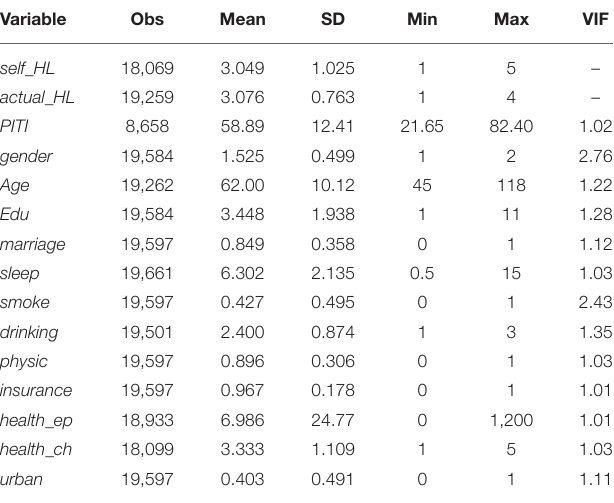
TABLE 4 | Descriptive statistics and multicollinearity test. Variable